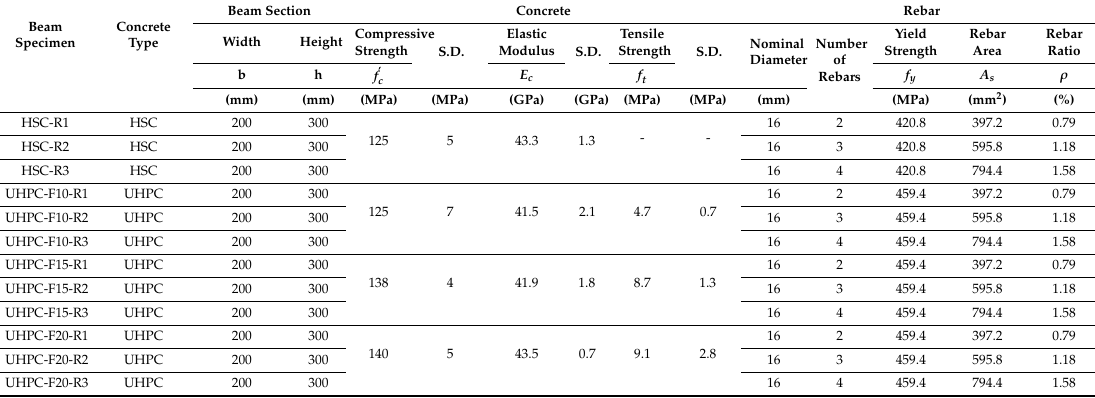
Table 3. Details of the